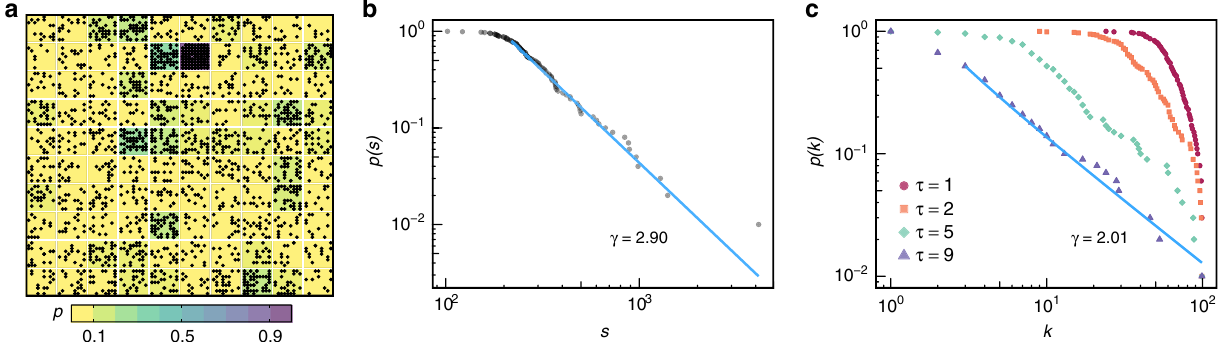
Fig. 2 Retrieving the probability of event generation in densely connected chronnets. a An example of a data set with a power-law distribution of event generation that creates a highly connected network. In these cases, the strength distribution of the resulting chronnets b provides a better description of the network. Another possibility is to consider a pruning threshold ( τ ) to remove weak links and to analyze the degree distribution. c Shows the degree distributions for τ = 1, 2, 5, and 9 represented by different colors and marks. The blue lines ( b and c ) represent the power-law fi tting. In both cases ( b and c ), it is possible to observe the original power-law distribution from the original data set ( a